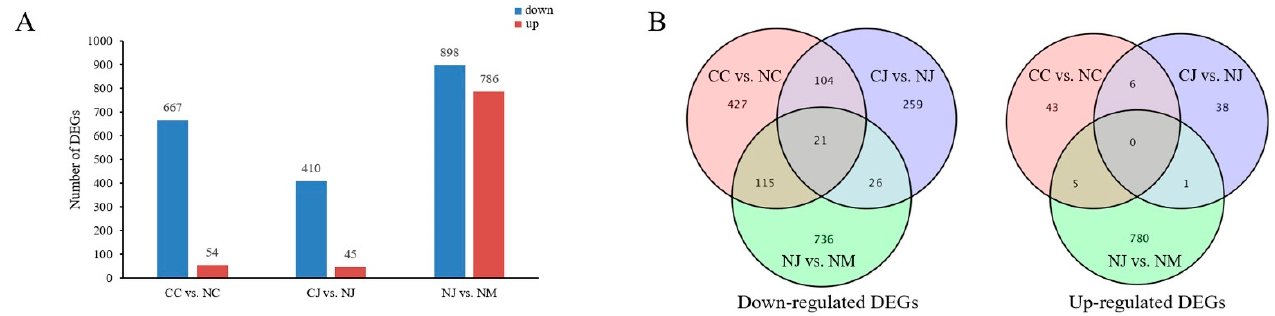
Figure 2. Analysis of DEGs in three jujube cultivars. ( A ) Numbers of DEGs in CC vs. NC, CJ vs. NJ, and NJ vs. NM. ( B ) Venn diagrams of DEGs numbers and distributions among three comparisons. 248